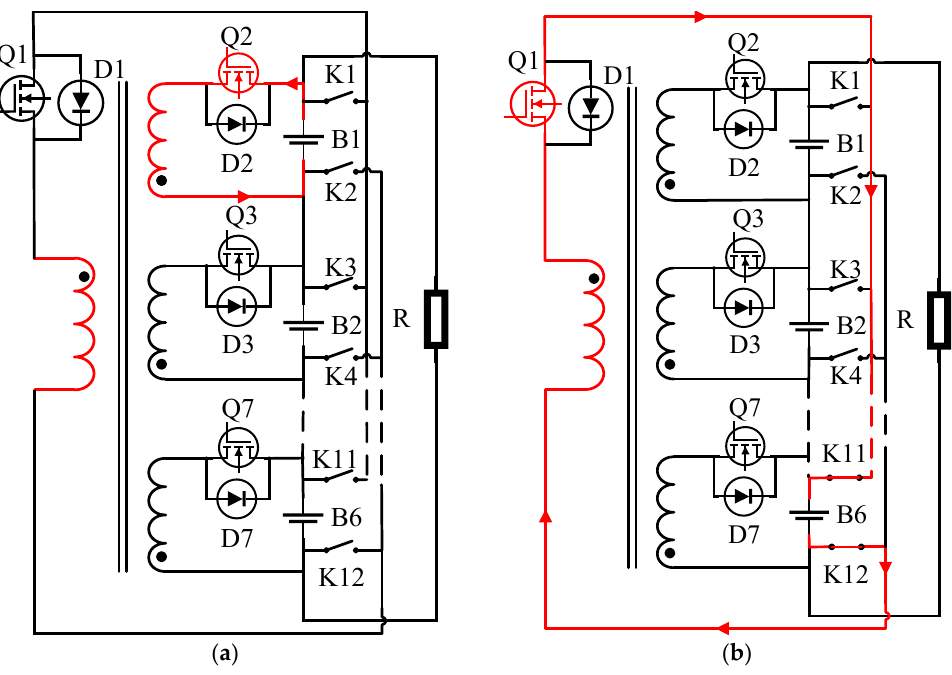
Figure 4. The working process of equalization mode 1. ( a ) Battery B1 discharges to primary winding. ( b ) Primary winding discharges to battery B6.